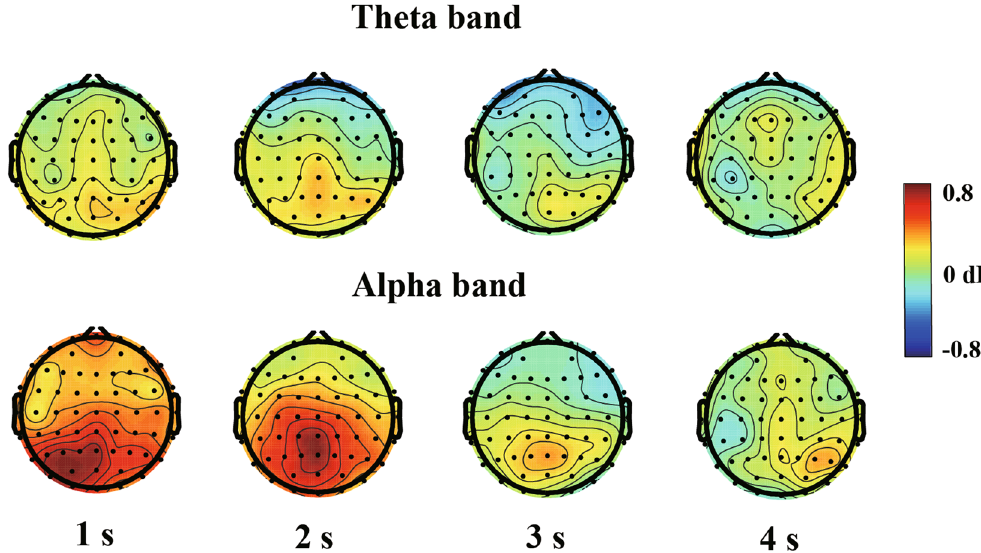
Figure 5. Topographies of theta and alpha activity during auditory duration maintenance in working memory in the 1-s, 2-s, 3-s, and 4-s conditions. Theta and alpha band powers are significantly activated in the posterior parietal cortex from the interval of 1 s to 3 s after the onset of delay.